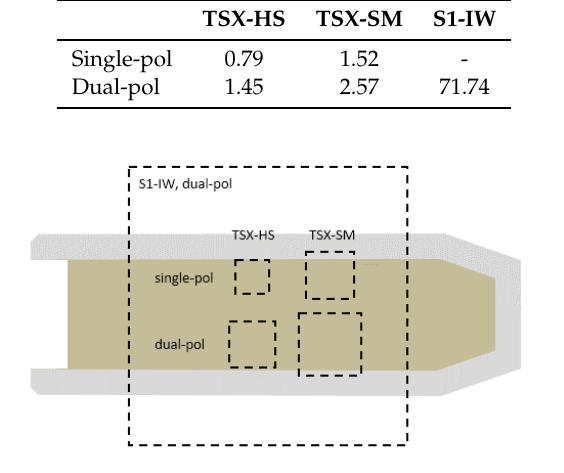
Table 2. Pixel size in m 2 of available acquisition modes after resampling.